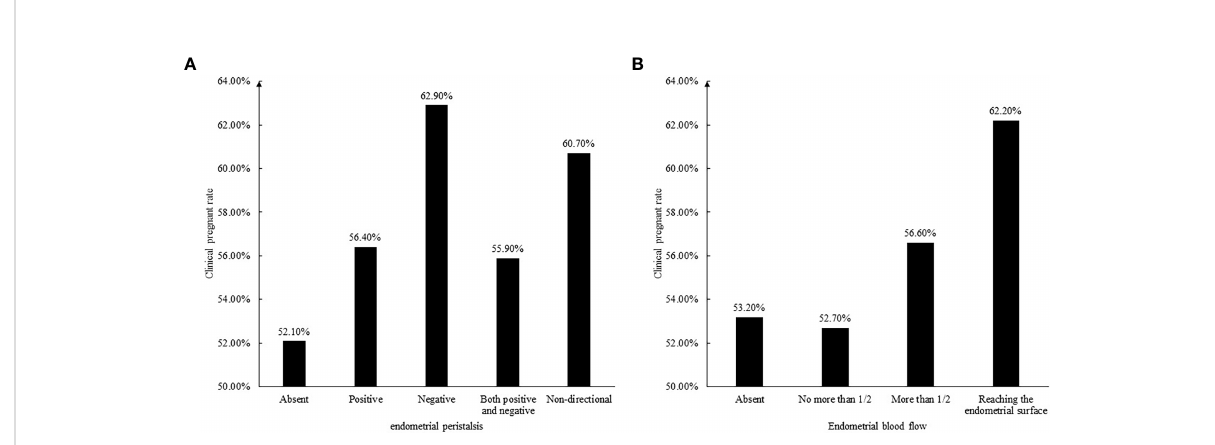
FIGURE 2 (A) The relationship between endometrial peristalsis and clinical pregnant rate. (B) The relationship between endometrial blood fl ow and clinical pregnant rate.